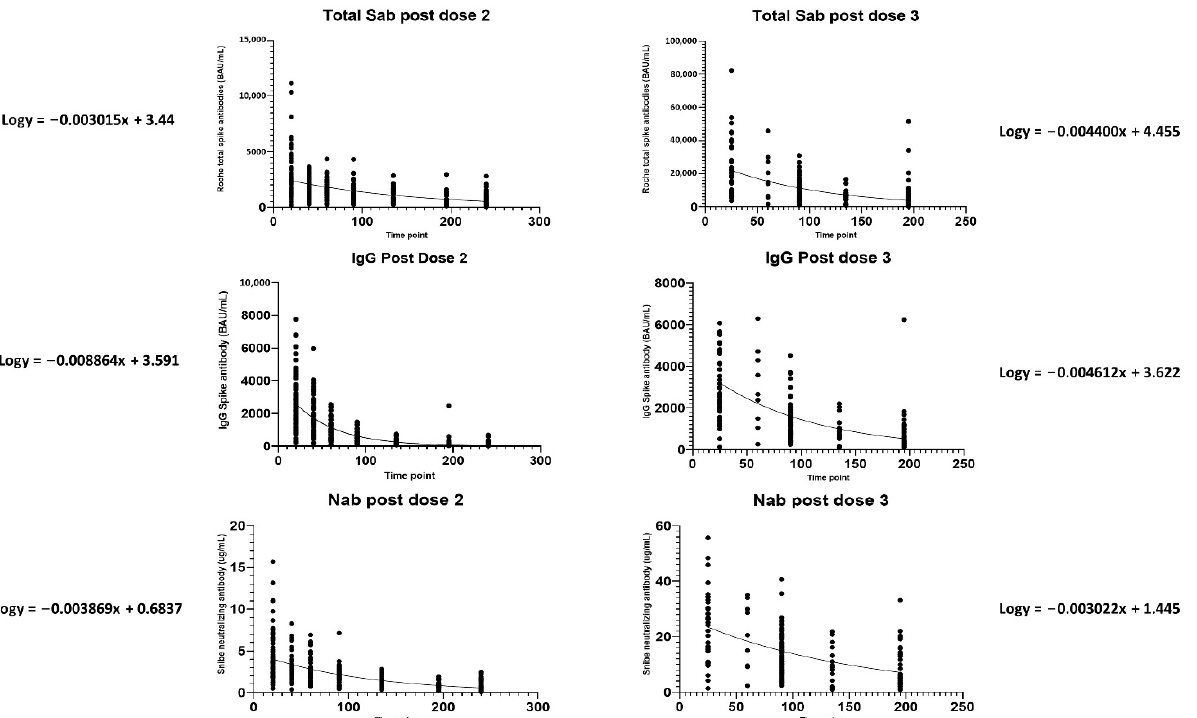
Figure 2: Non–linear regression analysis of the waning of total, IgG, and neutralizing antibodies after the second and third vaccinations, with associated regression equations.